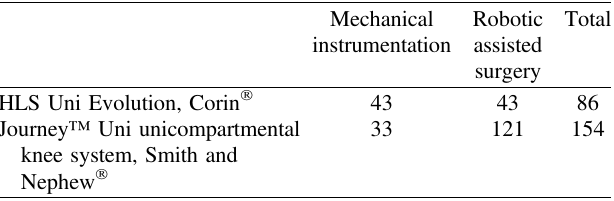
Table 2. Distribution of implants and surgical